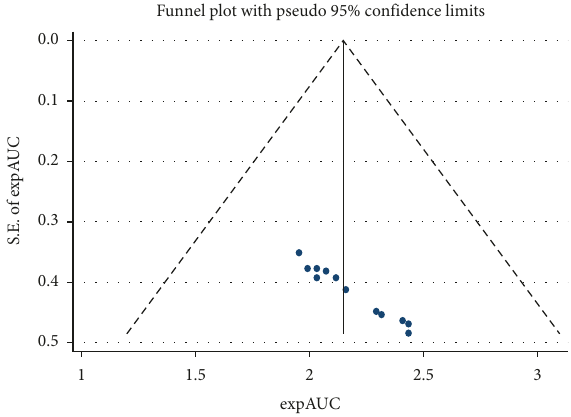
Figure 4: Funnel plot to assess the publication